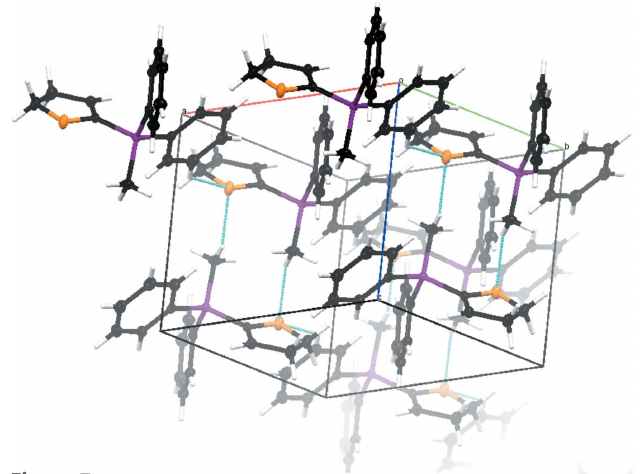
Figure 7 The crystal packing of compound 2 . C—H (cid:4)(cid:4)(cid:4) O hydrogen bonds are shown as dashed